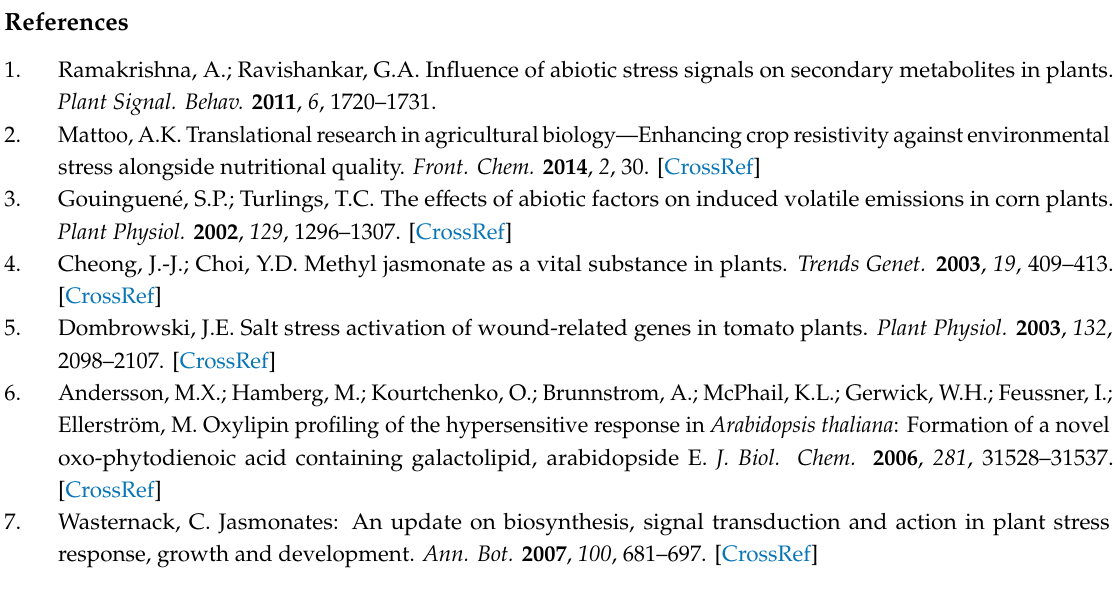
Table S1: List of genes and their primer sequences used for quantitative real–time PCR (qRT-PCR) analysis. Figure S1: Line Graphs for qRT-PCR analysis of tomato ( S. lycopersicum cv. Ailsa Craig) LOX gene family members in response to heat (42 ◦ C) treatment. Figure S2: Line Graphs for qRT-PCR analysis of tomato ( S. lycopersicum cv. Ailsa Craig) LOX gene family members in response to cold (4 ◦ C) treatment. Figure S3: Line Graphs for stress. Figure S4: Line Graphs for qRT-PCR analysis of tomato ( S. lycopersicum cv. Ailsa Craig) LOX gene family members in response to salt